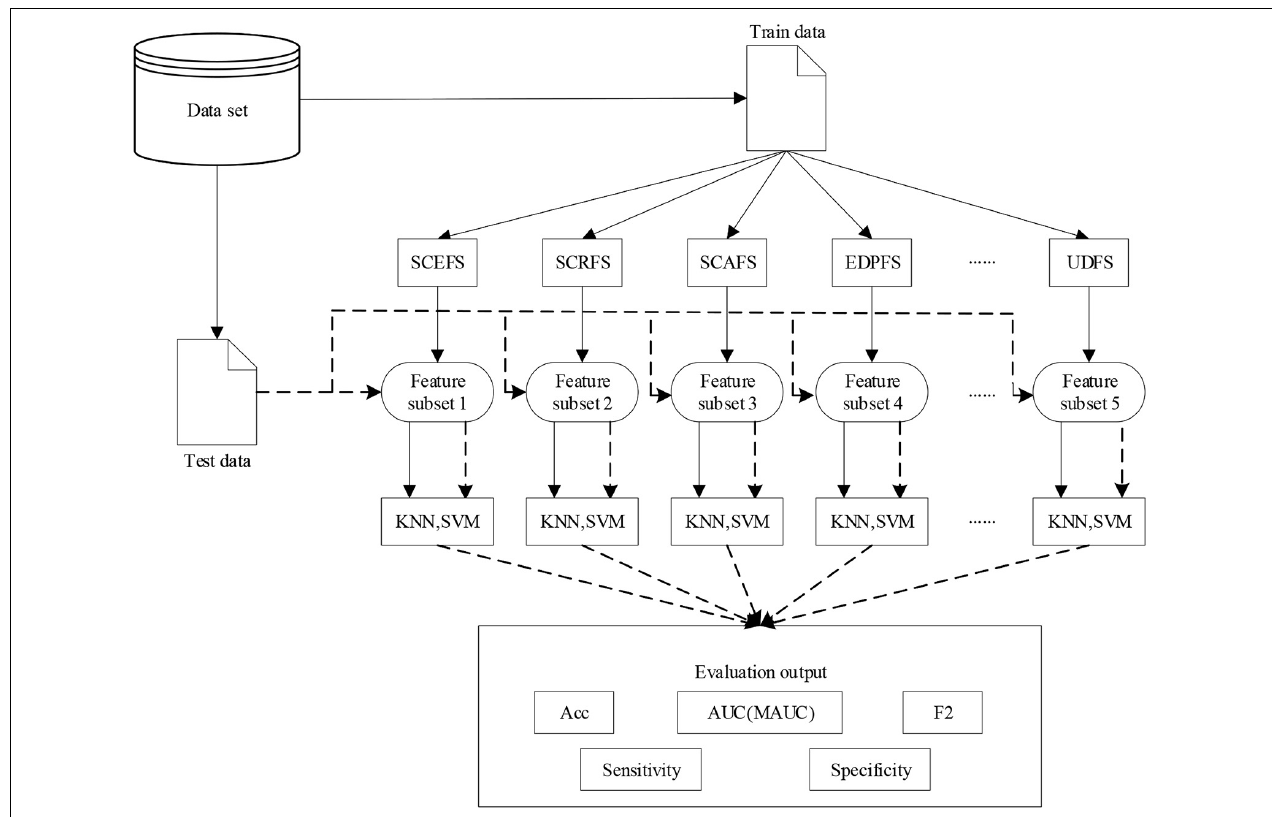
FIGURE 2 | The flow chart of the experiments in this